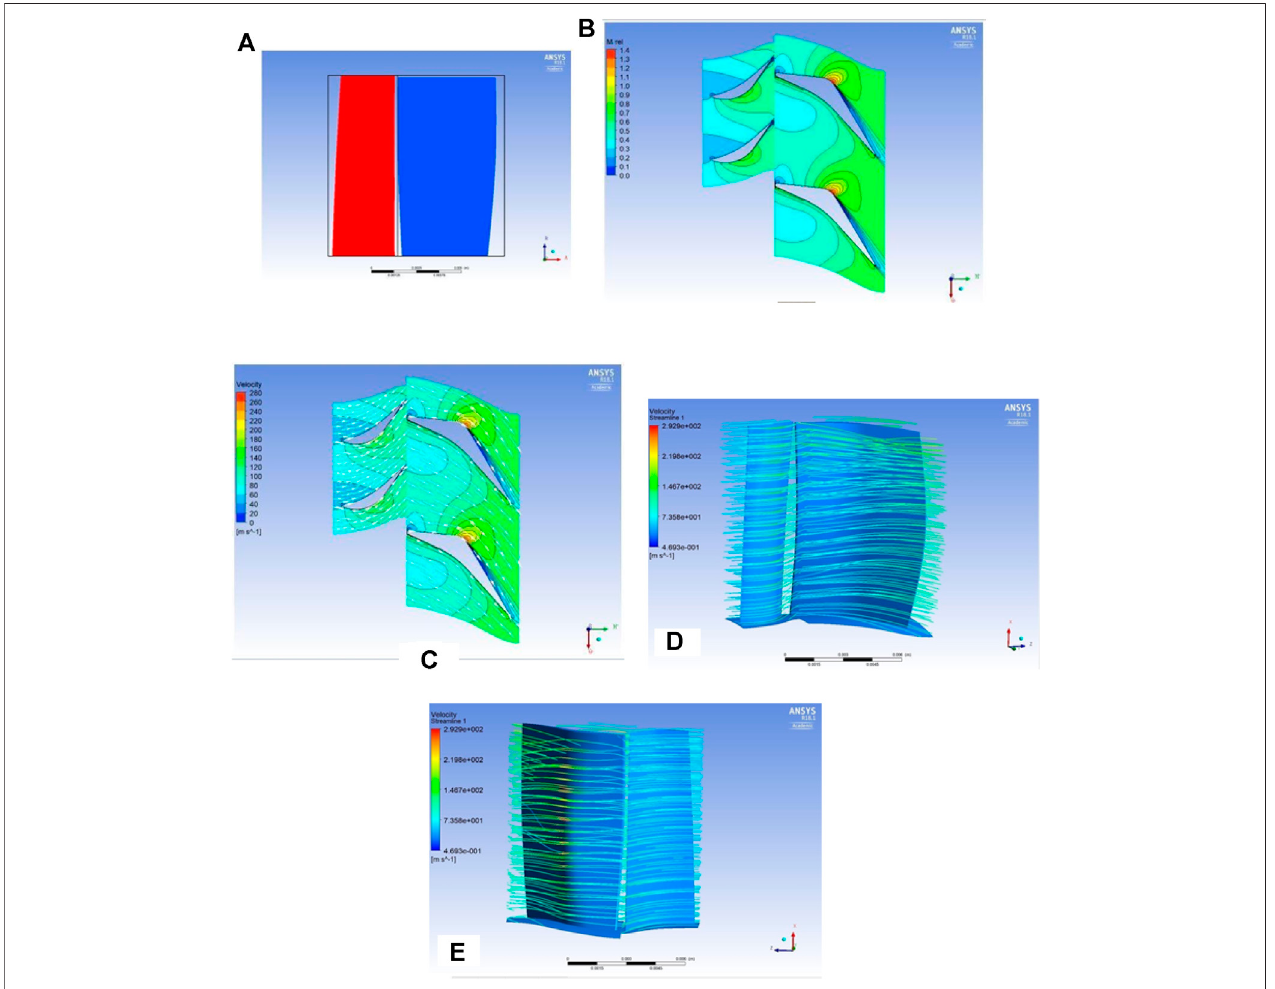
FIGURE 5 | (A) Meridional view of the turbine stator (red) and rotor (blue) and (B) relative mach number fi eld in stator-rotor couple and (C) velocity streamlines in stator-rotor couple; (D) velocity streamlines showing no vorticity, and (E) supersonic fl ow identi fi cation in a single rotor-stator couple.